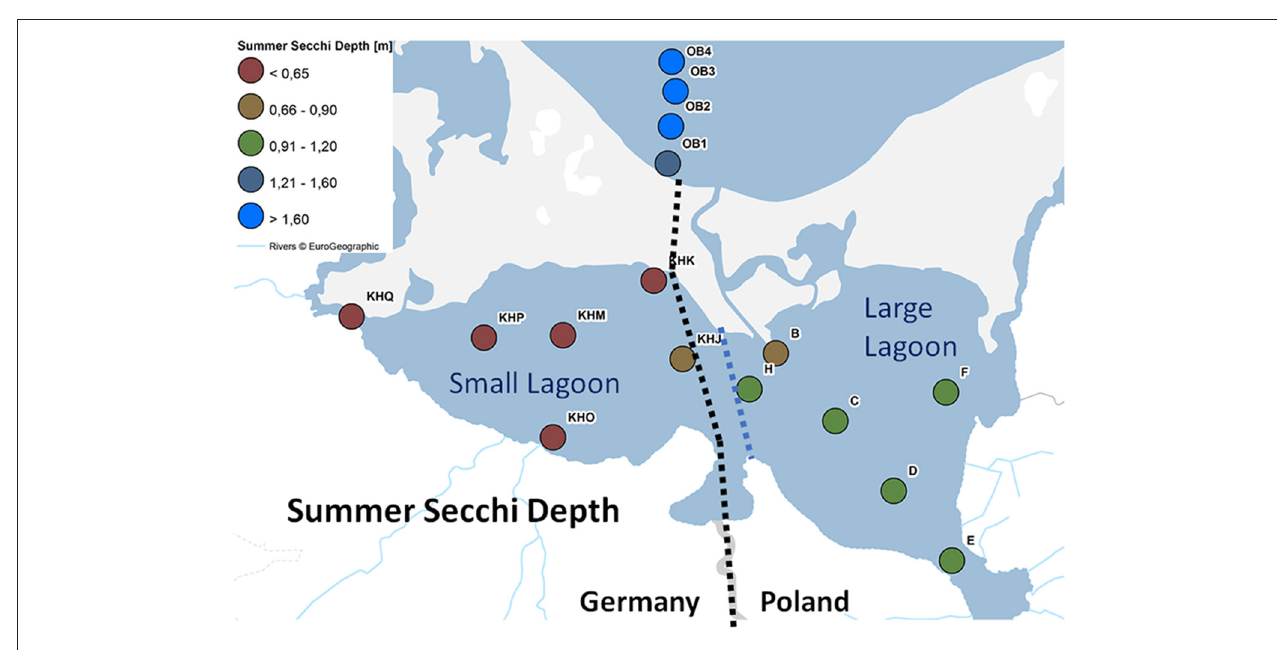
FIGURE 2 | Spatial distribution of water quality monitoring stations in Large Lagoon, Small Lagoon and Southern Pomeranian Bight color-coded by the mean Summer Secchi depth.